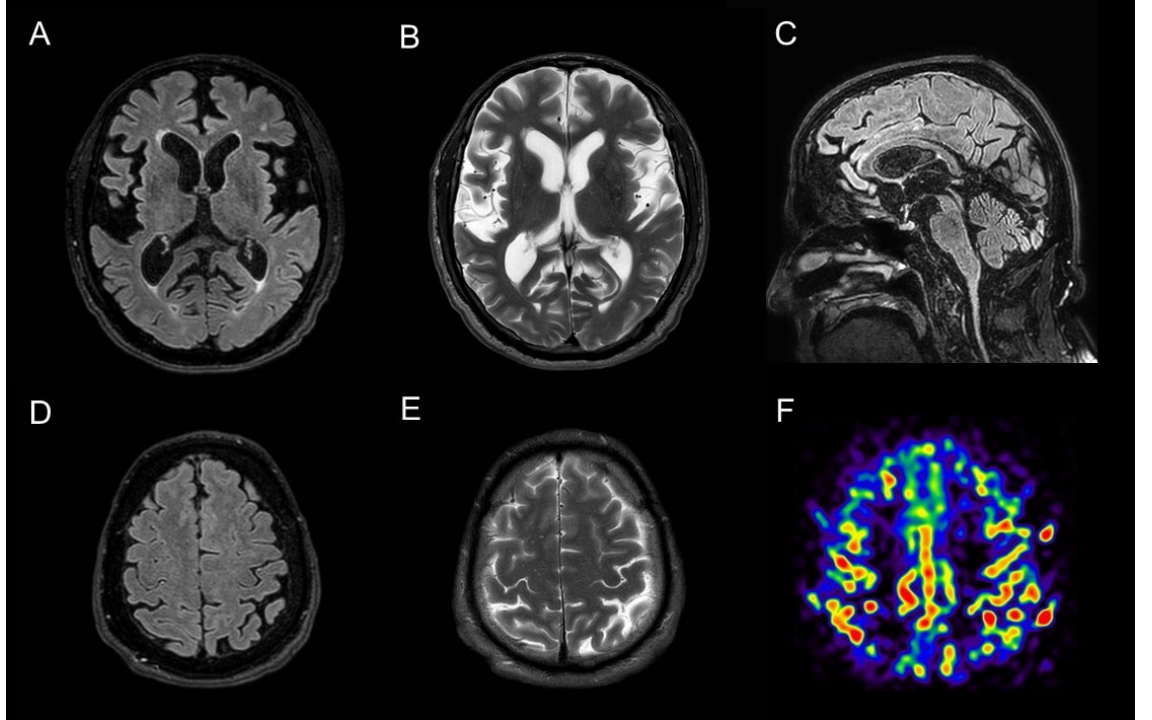
Figure 1. MRI findings in a case of anti-IgLON5 disease: ( A , B ) axial T1-weighted and T2-weighted sequences demonstrate marked temporal atrophy with relative preservation of other cortical regions; ( C ) sagittal T1-weighted brain MRI sequences show midbrain atrophy (the “hummingbird sign”); ( D , E ) axial T1-weighted and F T2-weighted sequences showed “high-convexity tight sulci”; “high-convexity tight sulci” is defined as the compression of sulci at the vertex, enlarged CSF spaces in the Sylvian fissure, and ventriculomegaly; ( F ) arterial spin labelling (ASL)-MRI documented hyperperfusion in the high-convexity area with relative preservation of other brain regions.